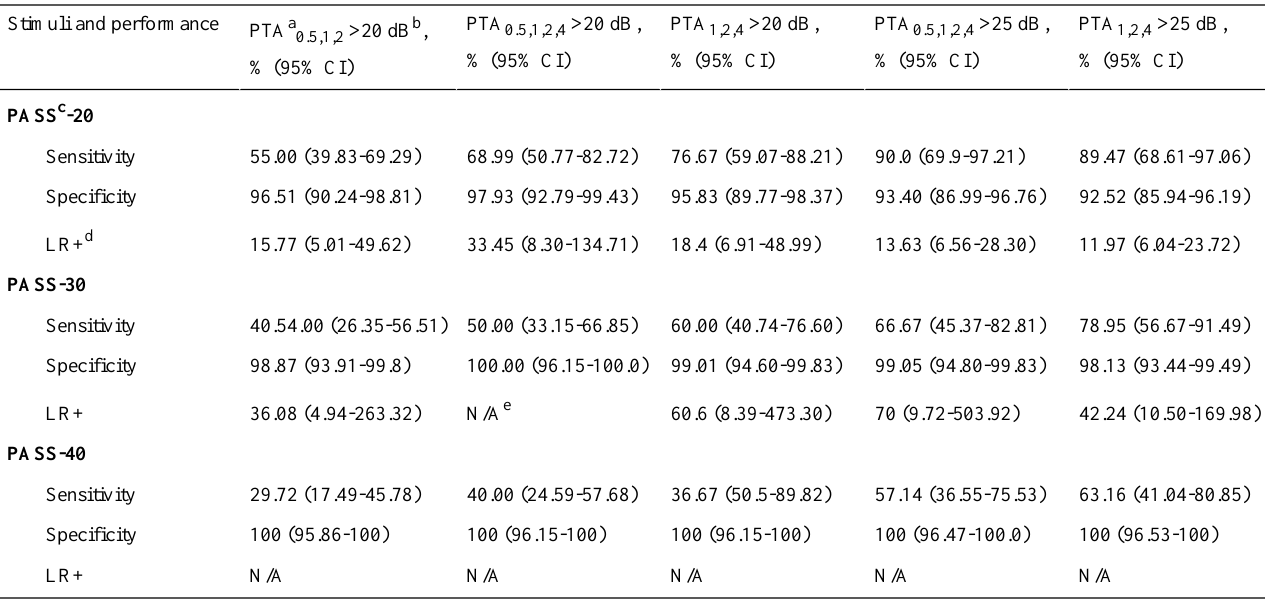
Table 4. The sensitivity, specificity, and positive likelihood ratio of Preschool Audiometry Screening System speech audiometry app version 2 compared with average pure-tone air-conduction threshold of different